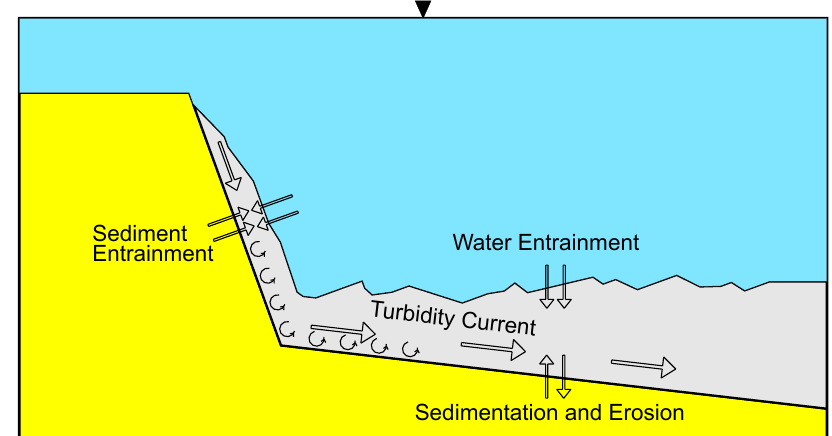
Figure 4. Conceptual sketch of the governing physics of a breaching